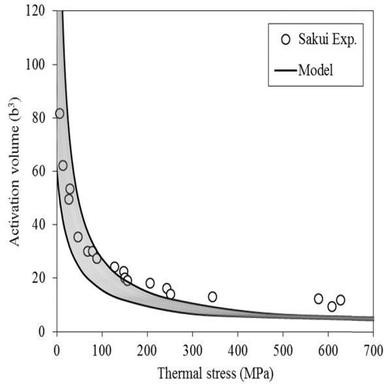
Thermal stress plotted against activation volume for pure iron: comparison of mechanistic model with experimental data from Sakui and Sakai.